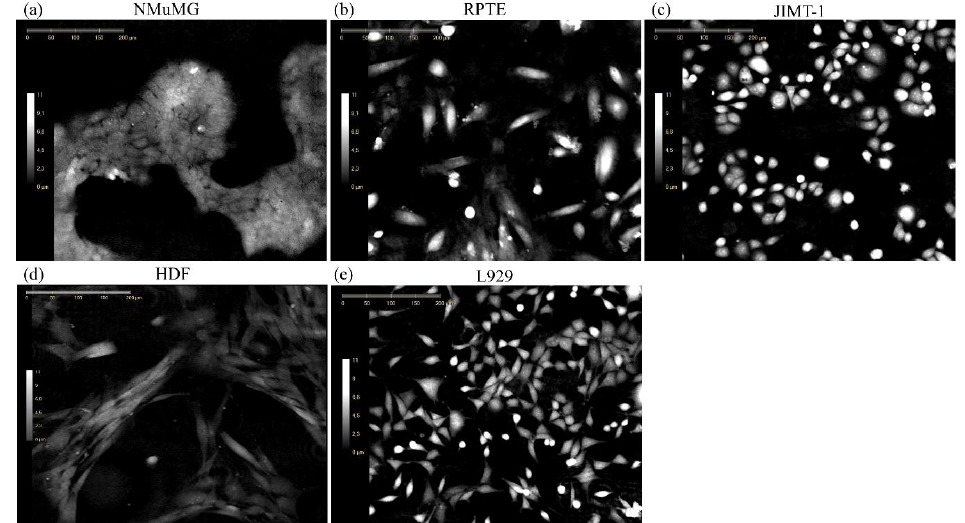
Figure 4. Representative digital holographic images show the five cell lines used in the NMuMG trained EMP classifier. The cells were seeded one day prior to start of the time-lapse imaging. Images were acquired at time-point: ( a ) 48 h, ( b ) 24 h, ( c ) 24 h, ( d ) 24 h, and ( e ) 48 h of the respective time-lapses. The scale bars are 200 µ m.